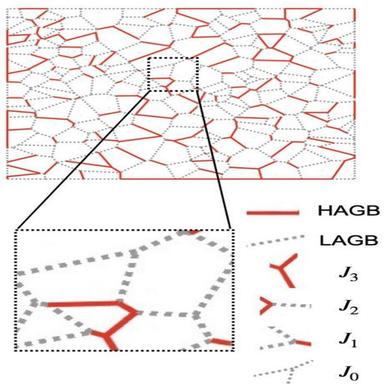
Illustration of possible microstructure configurations: (a) no grains, all polygons are cells; (b) grains and cells coexist; (c) no cells, all polygons are grains.